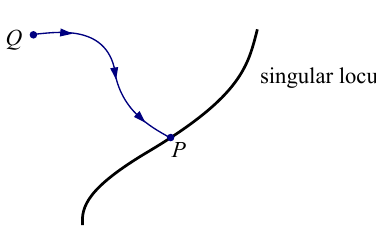
Figure 1 . Smooth path connecting a regular point Q to a singular point P which might be at in(cid:12)nite distance in moduli